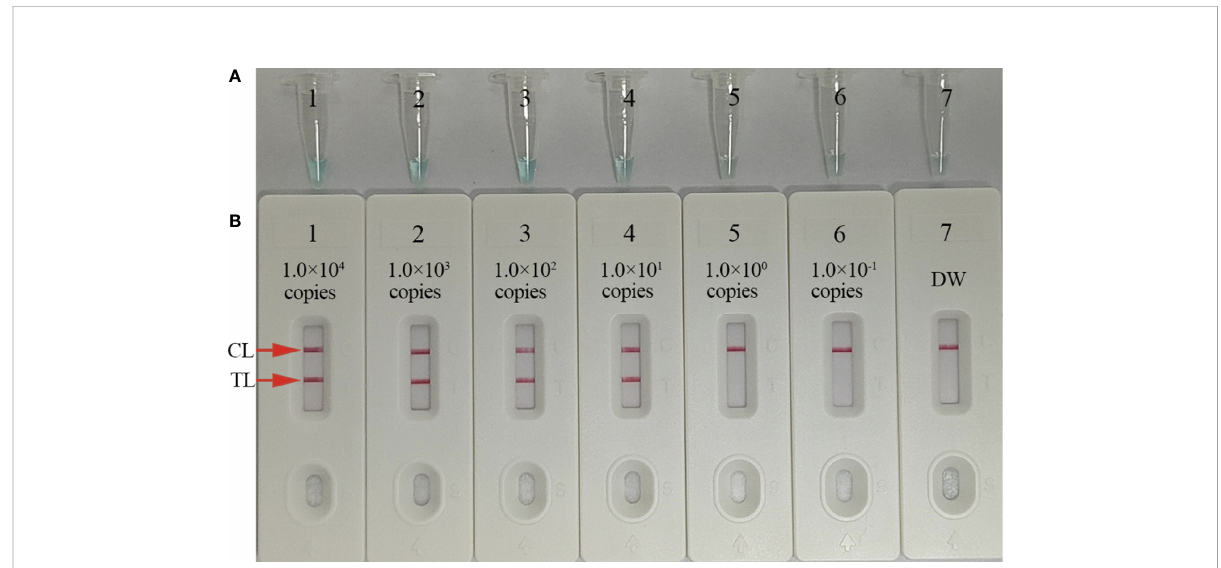
FIGURE 5 Sensitivity analysis of C trachomatis -MCDA-AuNPs-LFB using C trachomatis ompA -plasmid serial dilutions. Serial dilutions (1.0 × 10 4 , 1.0 × 10 3 , 1.0 × 10 2 , 1.0 × 10 1 , 1.0 × 10 0 , and 1.0 × 10 − 1 copies) of C trachomatis ompA -plasmids were used as templates, and distilled water (DW) was used as the negative control. Results were simultaneously analyzed by malachite green (MG) (A) and AuNPs-LFB (B) . The limit of detection (LoD) for C trachomatis -MCDA-AuNP-LFB was 10 copies/test. CL, control line; TL, test